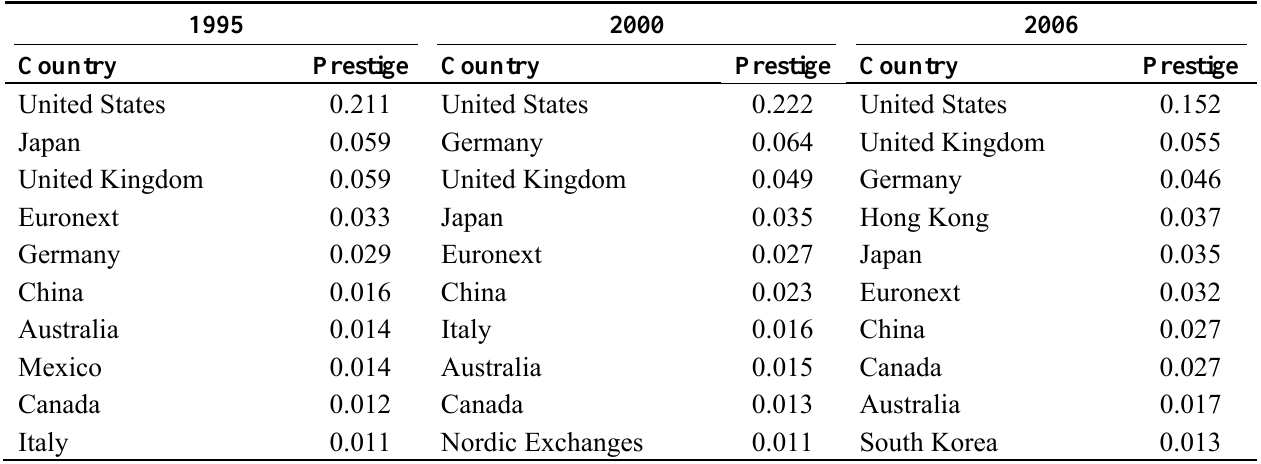
Table 4. Country Rankings Based on the Network Prestige Index of IPO